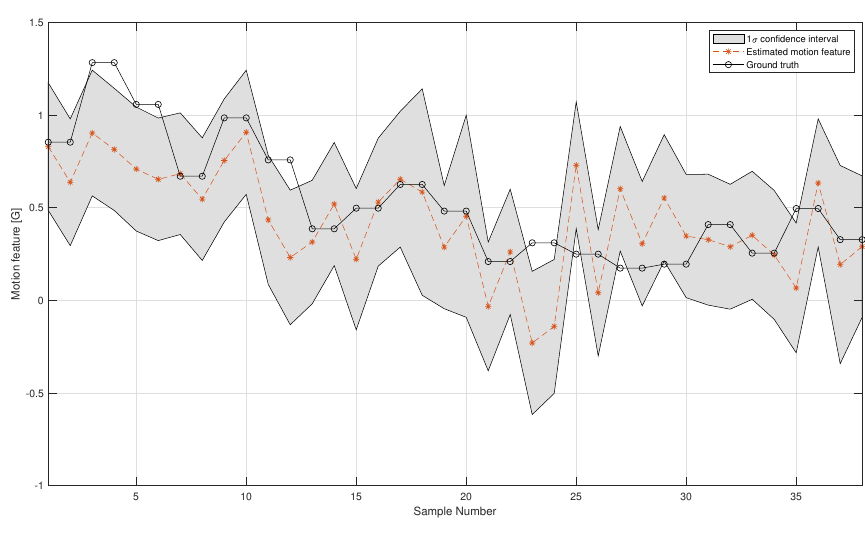
Figure 13. Prediction results for uniform terrains.